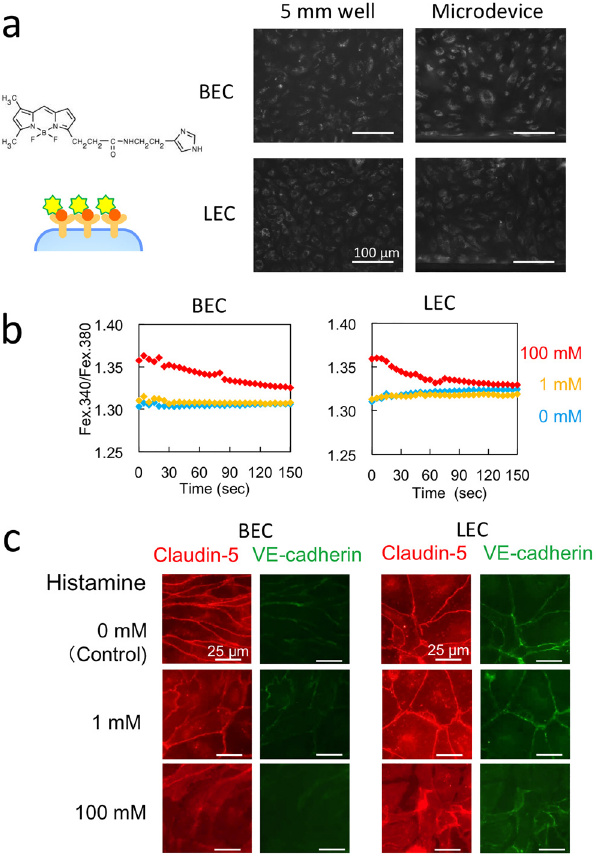
Fig 5. Effects of histamine stimulation on BECs and LECs cultured in the microfluidic system. A single-channel device without the permeable membrane was used instead of the coculture device. (a) Fluorescence imaging of BODIPY-FL-histamine bound to its receptor on BECs and LECs. (b) The time course of Ca 2+ responses to histamine stimulation observed in BECs and LECs. (c) Immunostaining for claudin-5 and VE-cadherin after histamine stimulation for 30